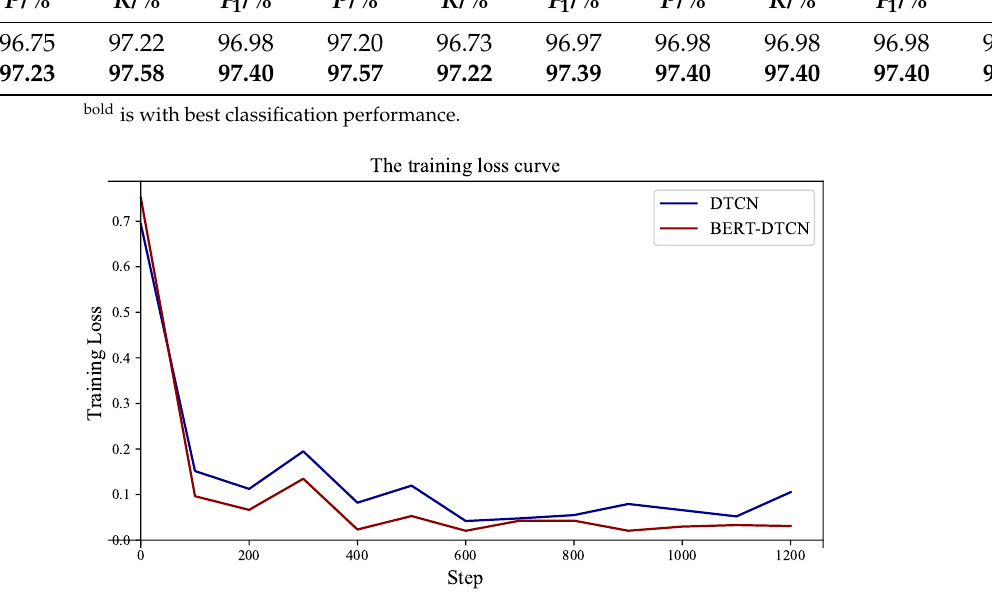
Figure 9. The training loss of DTCN and